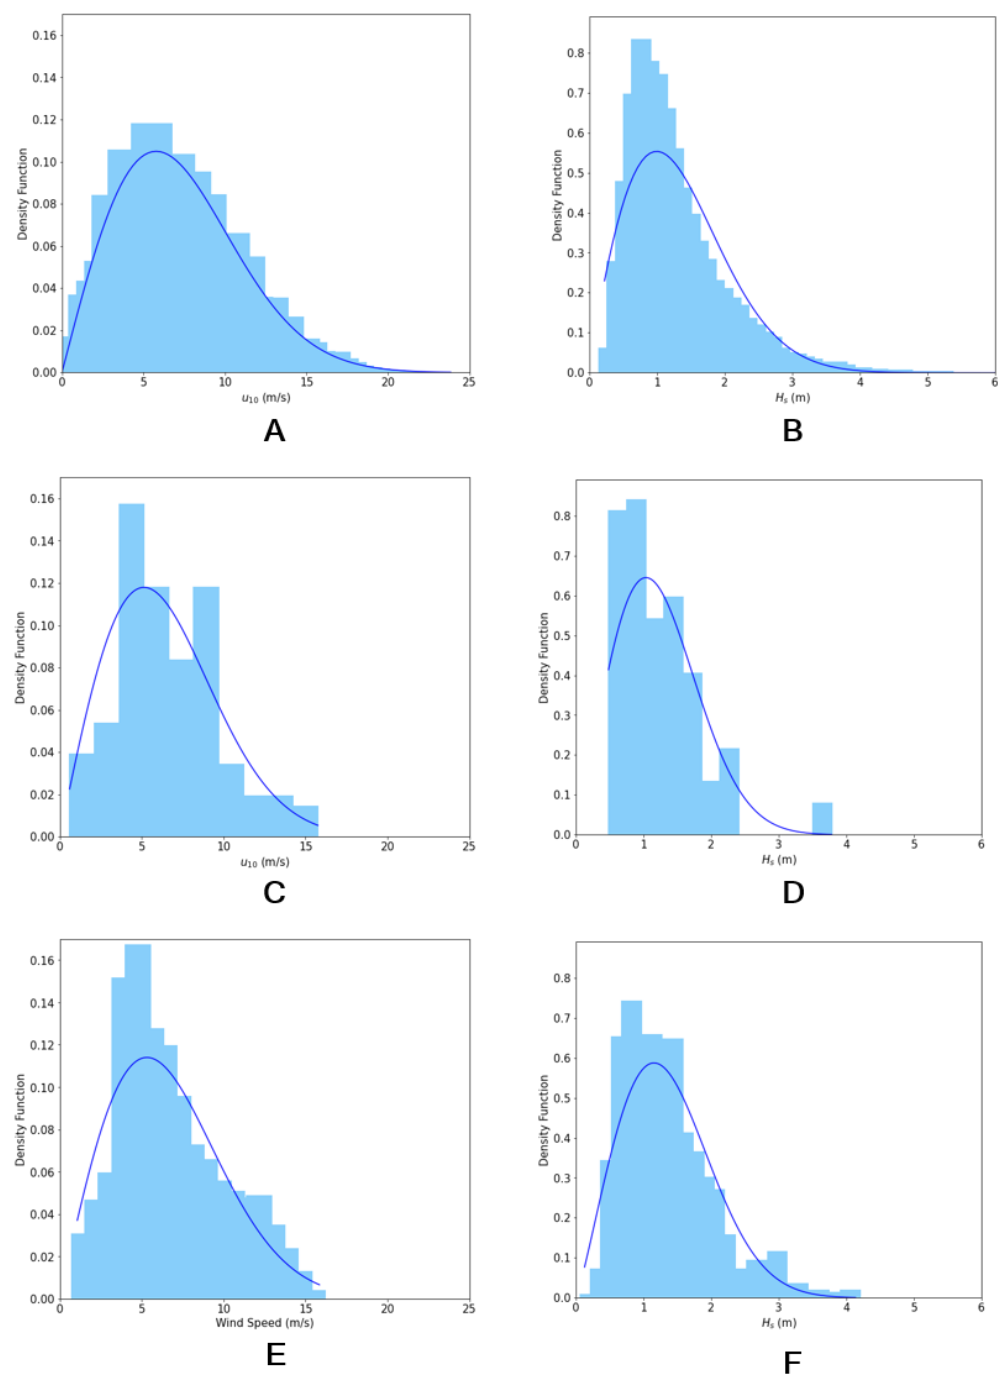
Figure 8. Probability density functions of (left) u 10 and (right) H s for Buoy 44017 for the period 2014–2019: ( A , B ) PDFs based on all the in situ data available for the period; ( C , D ) PDFs for the space and time matched cases of in situ observations; and ( E , F ) PDFs for all the matched AltiKa measurements. The fitting Weibull distribution curves defined in Table 5 are also